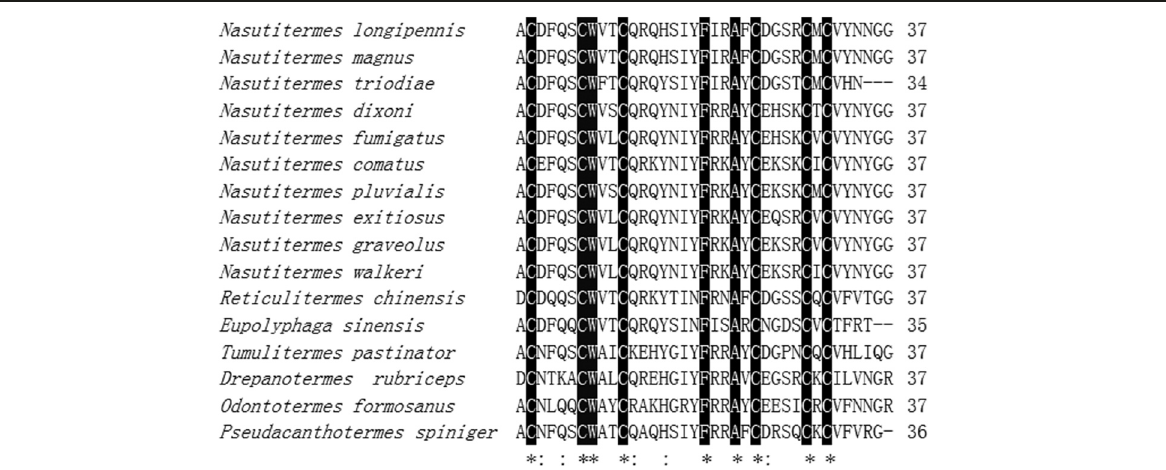
Fig. 3 Sequence alignment of Termicins. The sequences used in the alignment are from Eupolyphaga sinensis (this work), N. comatus (GenBank accession no. AY642891), N. dixoni (GenBank accession no. AY642893), N. exitiosus (GenBank accession no. AY642894), N. fumigatus (GenBank accession no. AY642896), N. graveolus (GenBank accession no. AY642897), N. longipennis (GenBank accession no. AY642898), N. magnus (GenBank accession no. AY642899), N. pluvialis (GenBank accession no. AY642900), N. triodiae (GenBank accession no. AY642902), N. walkeri (GenBank accession no. AY642904), Tumulitermes pastinator (GenBank accession no. AY642908), Drepanotermes rubriceps (GenBank accession no.